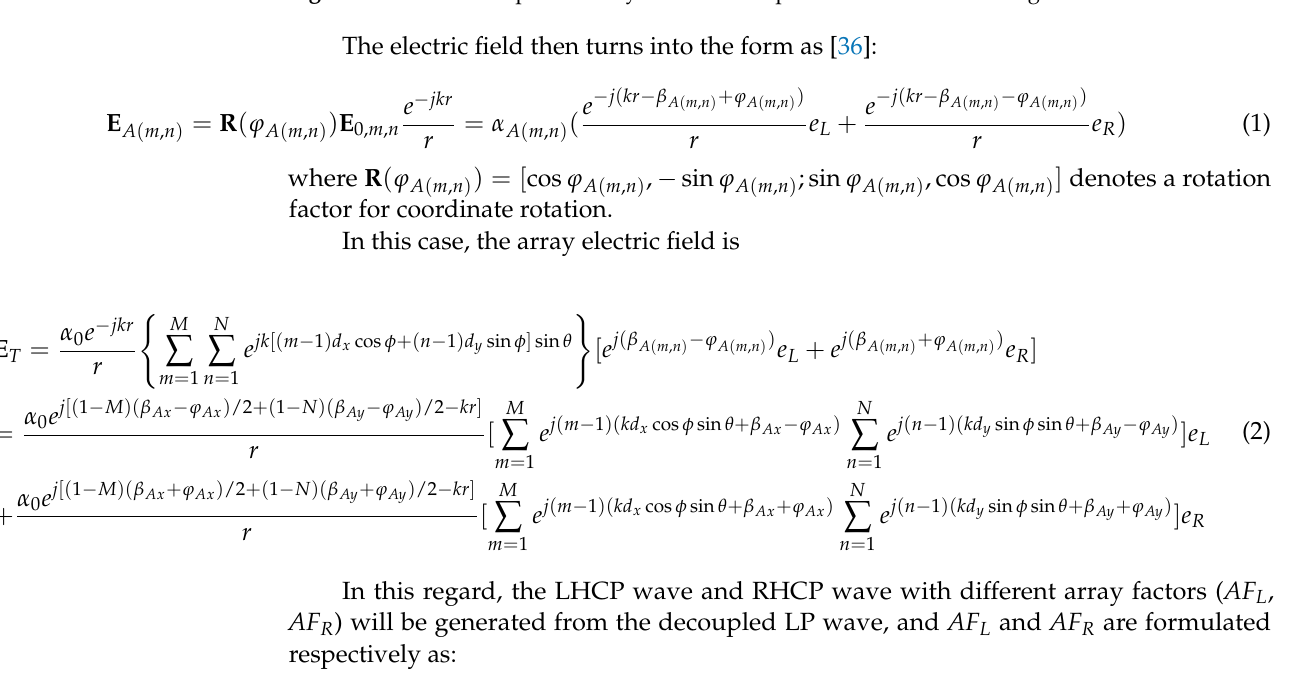
Figure 1. Schematic of planar arrays that are composed of dual LP radiating